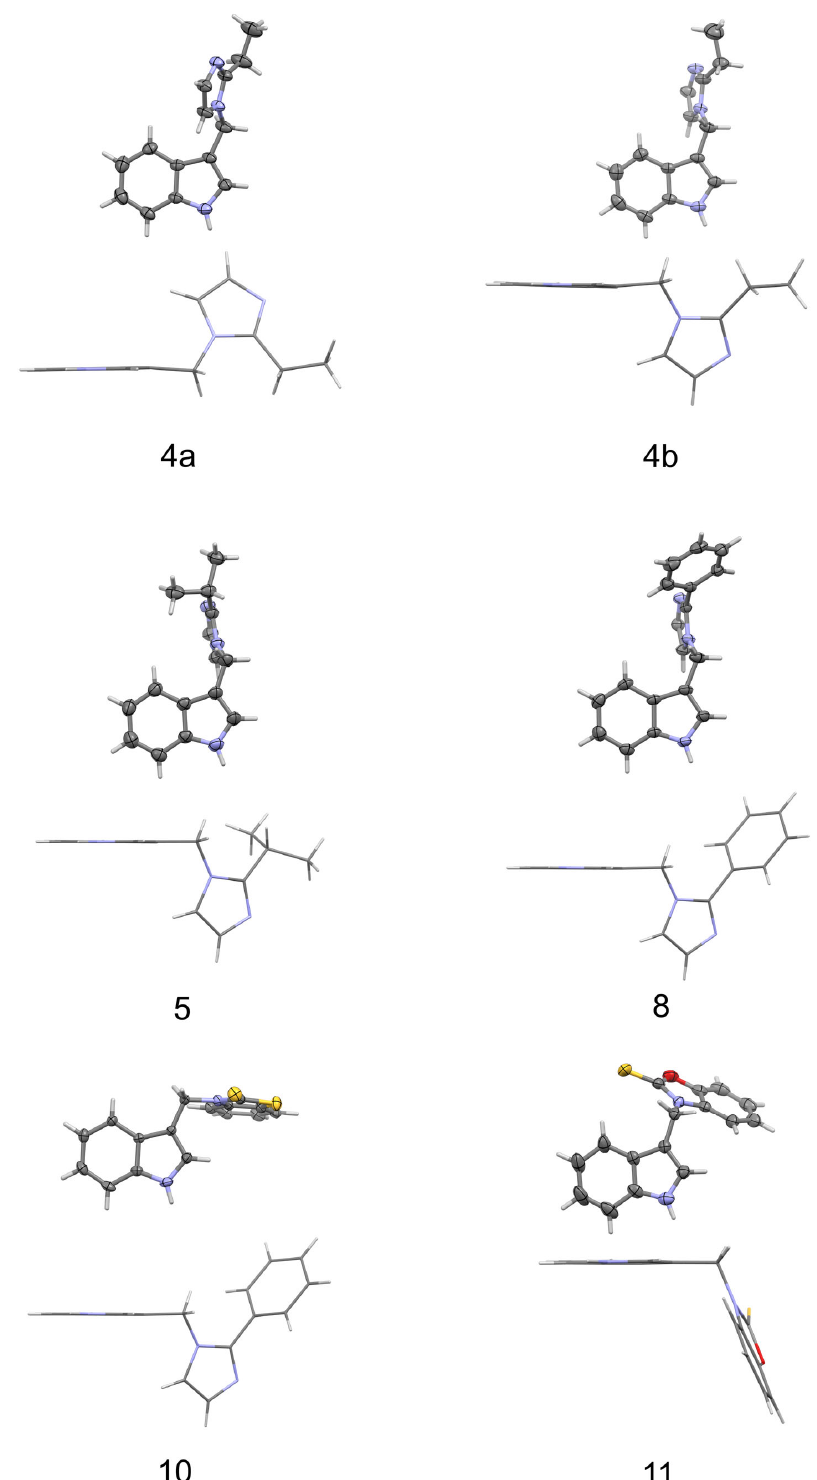
Figure 3. Molecular conformation as present in crystals of compounds 4 (two independent molecules 4a and 4b), 5 , 8 , 10, and 11 in two representations (i.e., viewed perpendicular (above) and parallel (below) to the indole plane). Thermal ellipsoids are drawn at the 30% probability level. The molecular conformation markedly changes with the replacement of imidazole fragments by either benzothiazole-2-thione ( 10 ) or benzoxazole-2-thione ( 11 ). While in the imidazole derivatives ( 4 , 5 , and 8 ), the imidazole ring lies almost in the